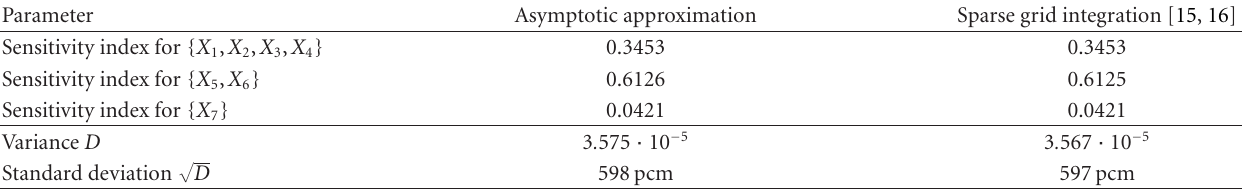
Table 1: Sensitivity indices and output uncertainty (both dimensionless) as calculated with the asymptotic formula and multidimensional